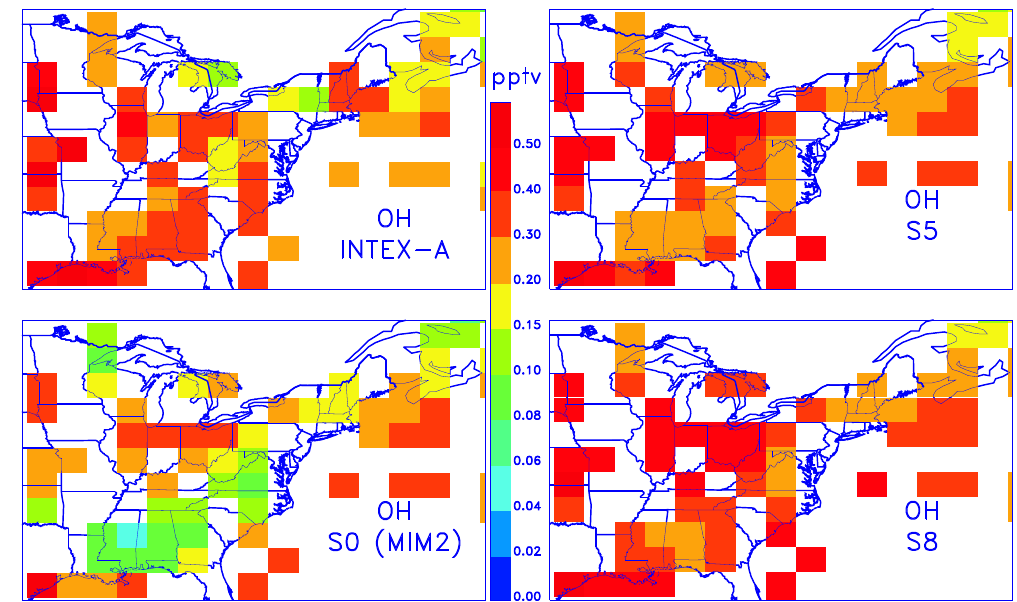
Fig. 7. Comparison of OH concentrations (below 1km altitude, 9–17LT average) measured during the INTEX-A campaign (top left), and modelled with IMAGESv2 using MIM2 (S0, bottom left), LIM0 (S5, top right), and LIM0 with halved isoprene emissions (S8, bottom right).